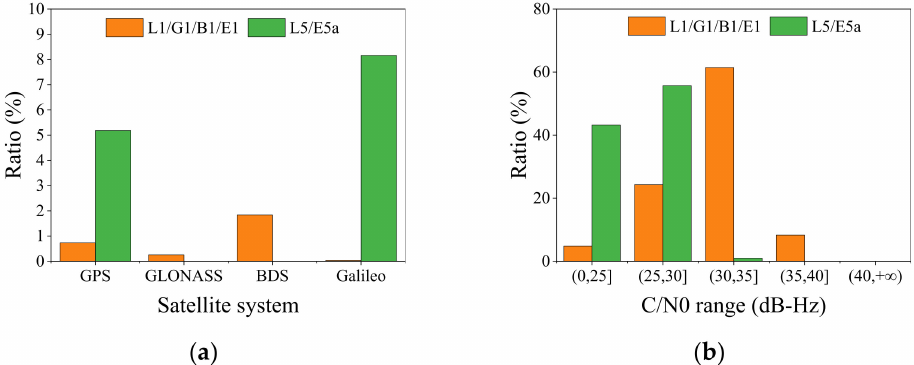
Figure 5. Statistical results of cycle slips for four constellations. ( a ) Ratio of cycle slips to number of observations. ( b ) Ratio of cycle slips to number of cycle slips in various C/N0